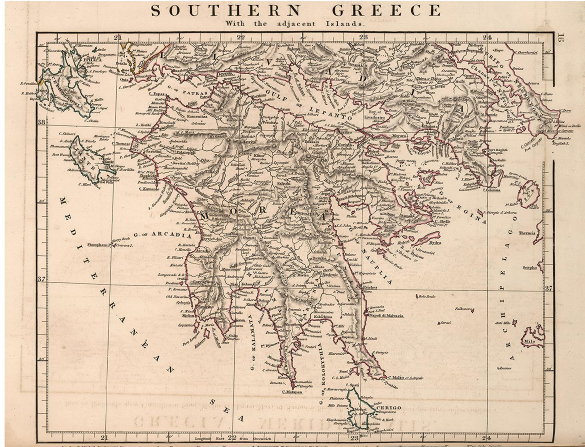
Figure 5 . Arrowsmith, Aaron Jr., Southern Greece, with the adjacent Islands, London, 1828. Cartography of Greece.